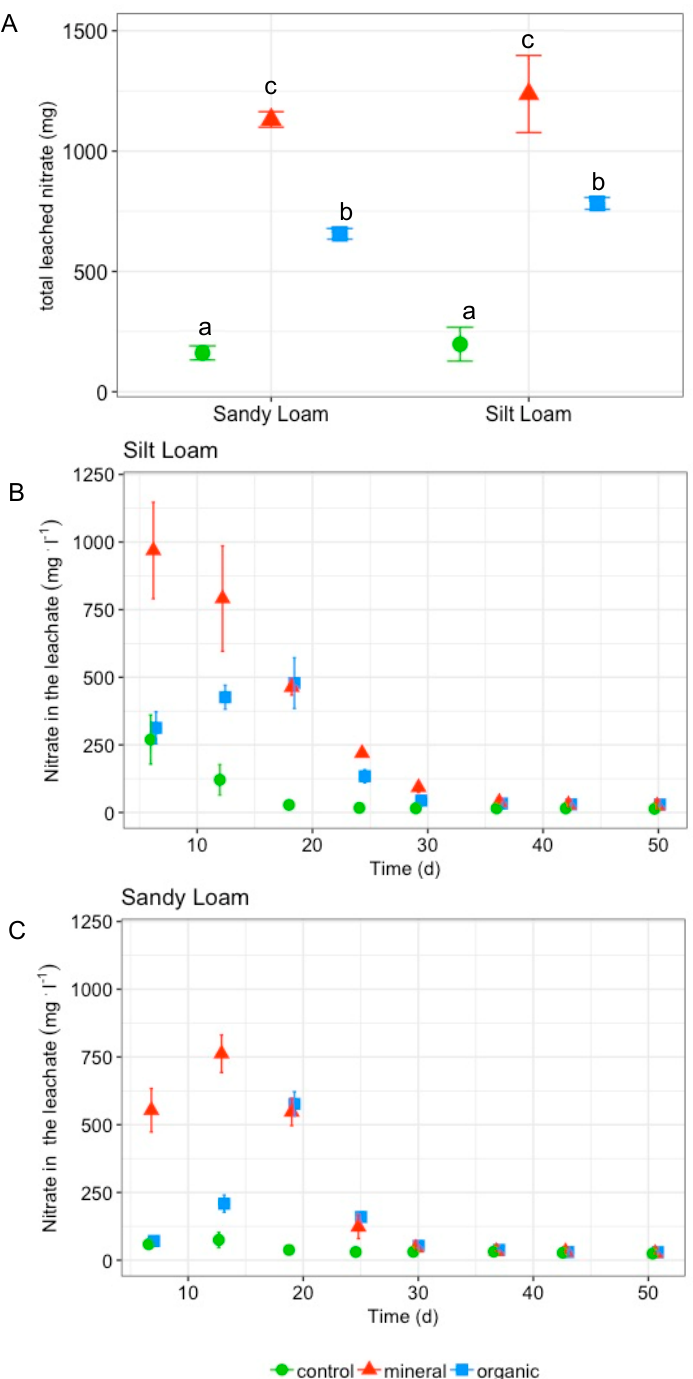
Figure 2. Mean ( ± SD) nitrate (NO 3 − ) of the soil leachate: ( A ): Mean ( ± SD) totally NO 3 − amount: a summation of all time series within each treatment (left: sandy loam; right: silt loam); statistical significance of di ff erence between treatments are indicated with letters (Tukey; p ≤ 0.05; silt loam: n = 21, sandy loam: n = 28). ( B , C ): temporal response curve of the mean ( ± SD) NO 3 − concentration in the soil leachate percolating through silt loam (( B ), n = 3) and sandy loam (( C ), n = 4). Shapes indicating di ff erent fertilizer application: control (circle); mineral (triangle) and organic (square). In silt loam, DOC concentrations in the leachate of fertilized soil cores were about half those of the control during the first 19 days and then increased to the same levels as the control (TukeyHSD, p ≤